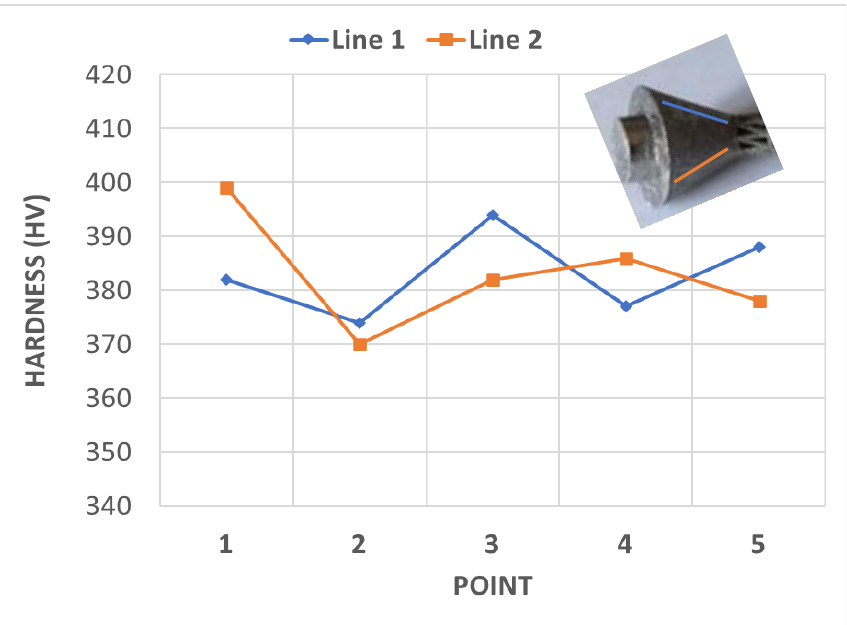
Figure 12. Results of hardness analysis at the two lines highlighted at the head of the